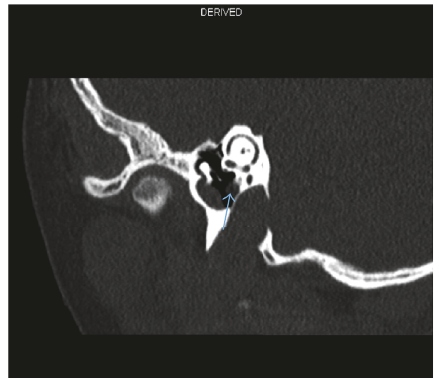
Figure 3: Limited coronal CT scan of right ear revealing a lesion in the area of the second genu of the facial nerve (blue